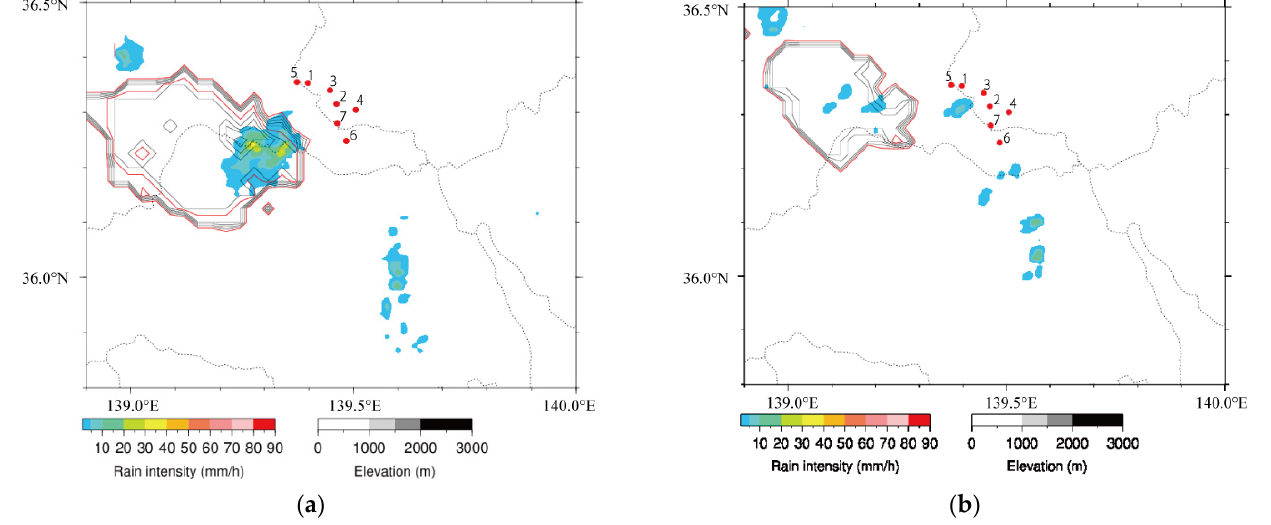
Figure 9. Distribution of rain intensity at 2 km height estimated by C-band radar at 1:40 (LT) (Panel ( a )) and 2:10 (LT) (Panel ( b )) on 27 August 2020. Black and red lines represent echo-top height in every 1 km and 5 km, respectively.